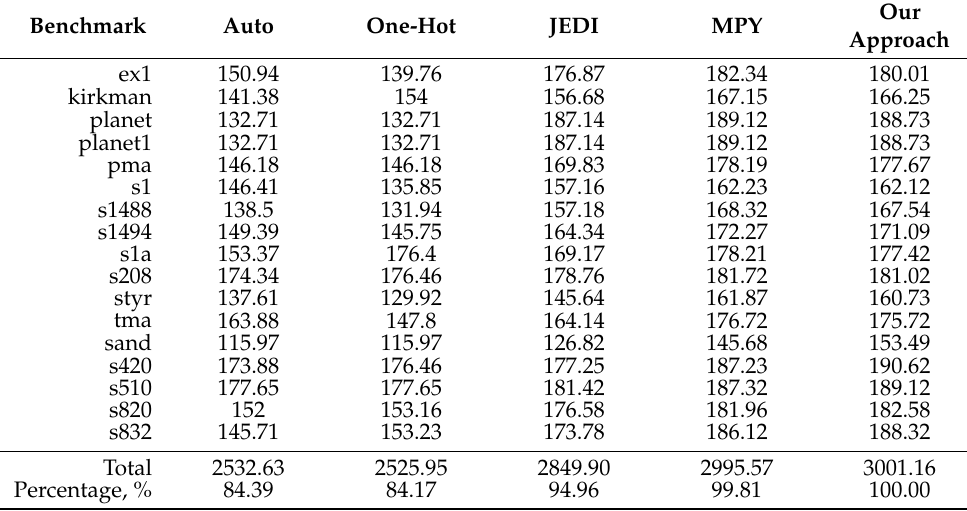
Table 16. Experimental results (the maximum operating frequency for BM3-BM5,